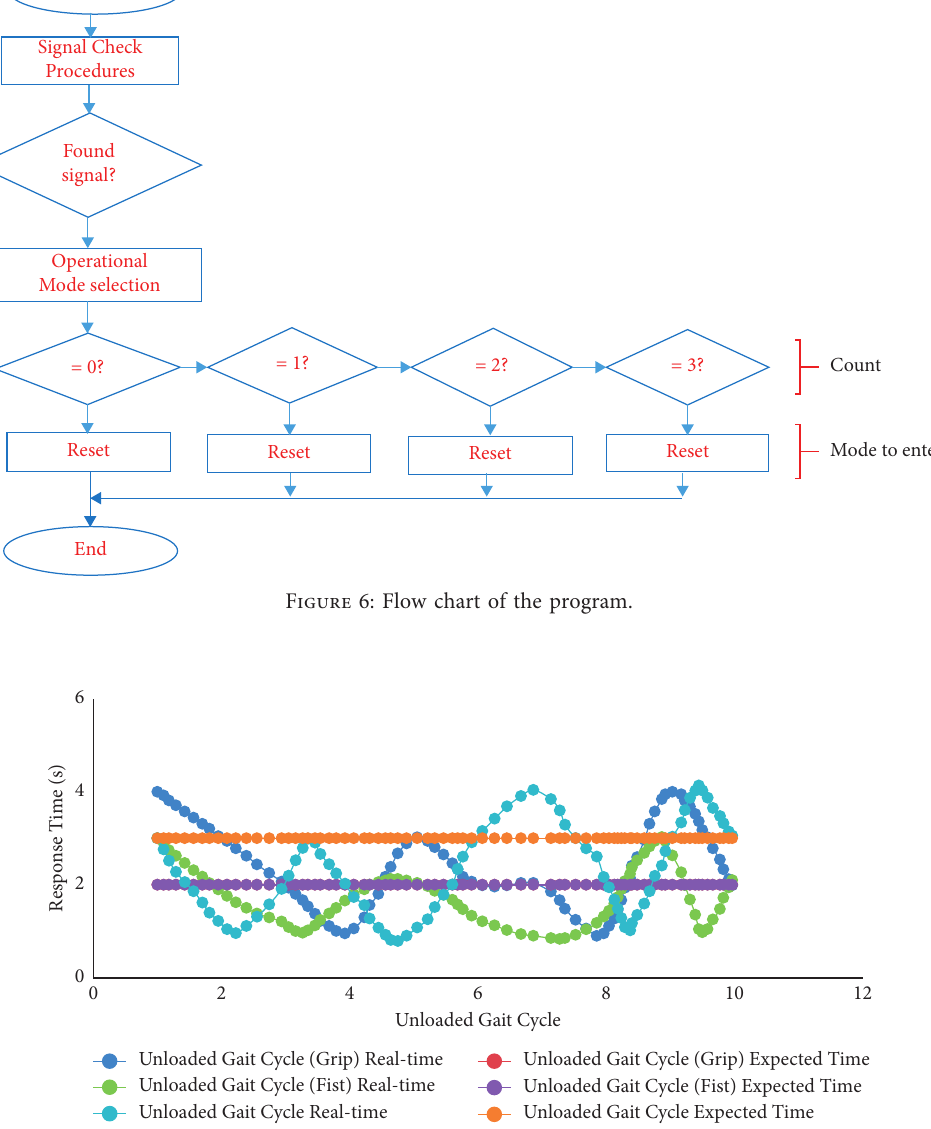
Figure 7: Expected time of a grip against real-time response for selected gripping and loading